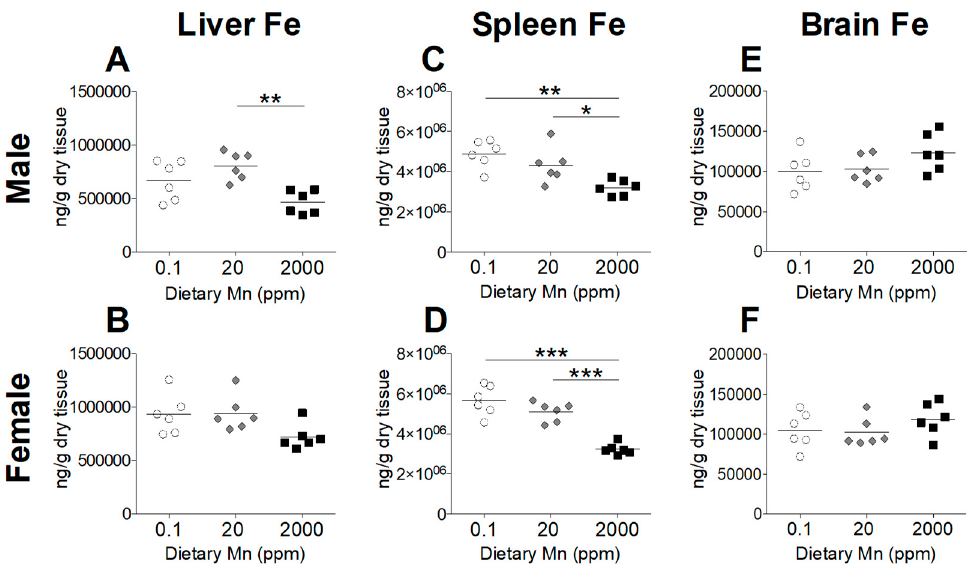
Figure 5. Tissue Fe levels in mice on 0.1, 20, and 2000 ppm Mn diets. Fe content measured by ICP-MS in male and female mice at 12 weeks of age ( n = 6/sex). (A and B) Liver. (C and D) Spleen. (E and F) Brain. Data expressed as mean ± SEM. * p < 0.05, ** p < 0.01, *** p < 0.001.